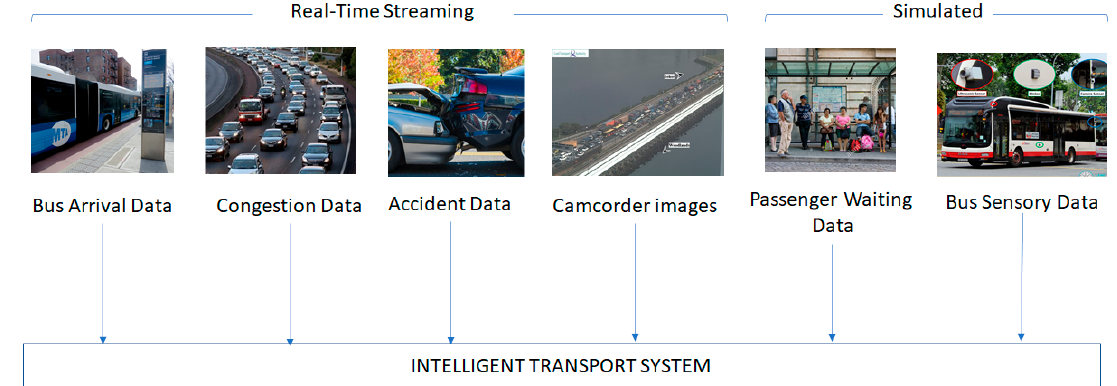
Figure 7. Input data stream for use case of MOBDA.